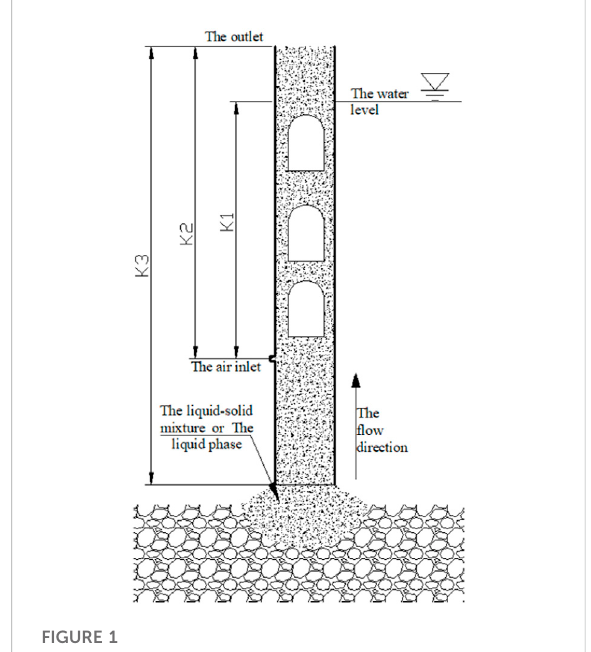
FIGURE 1 Schematic diagram of the air-lifting